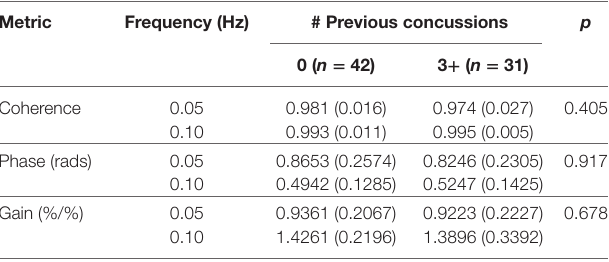
Table 3 | Summary preseason data for transfer function analysis outcomes in the athletes with 0 vs. 3 + previous